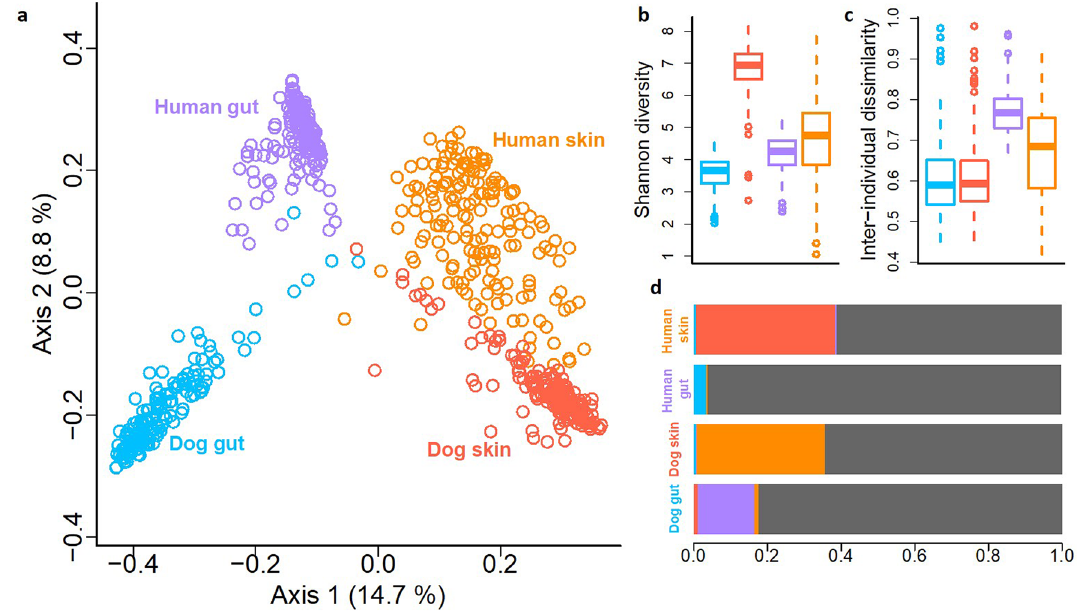
Figure 3. An overview of skin and gut microbiota differences between pet dogs and humans. The Principal coordinate analysis ( a ) shows separation between skin and gut microbiotas as well as between dogs and humans. Dog skin has clearly the highest Shannon diversity in comparison to other studied microbiotas ( b ). The inter- individual variation is higher between humans than dogs ( c ). The Bayesian source tracking analysis between studied microbiotas shows that skin microbiota of dogs and humans can originate from each other while gut microbiotas, especially in humans, are mostly independent (i.e. the proportion of unknown source, grey, was large) ( d